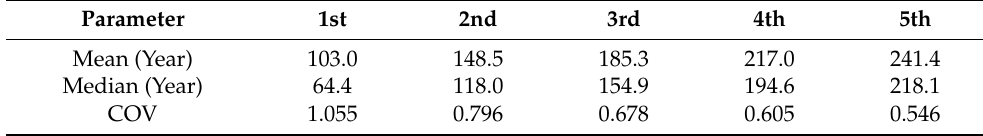
Table 5. Mean, median, and COV of predictions of the first five breaks for the example water main. Parameter